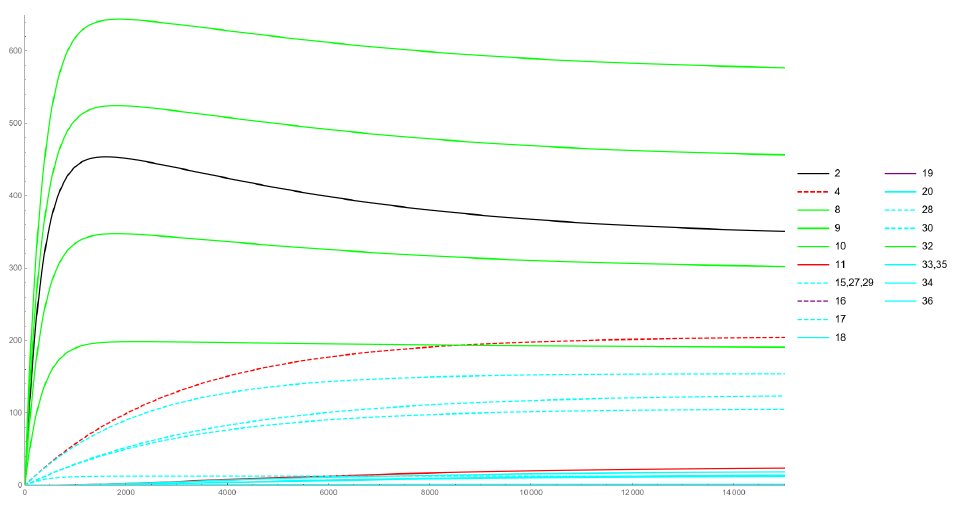
Figure 3. Physiological case.